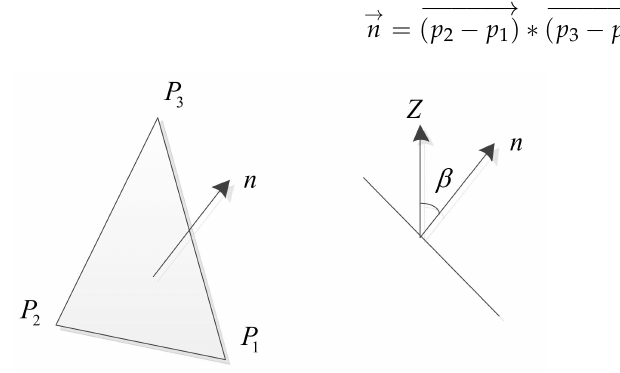
Figure 4. Schematic diagram of normal vector of triangle